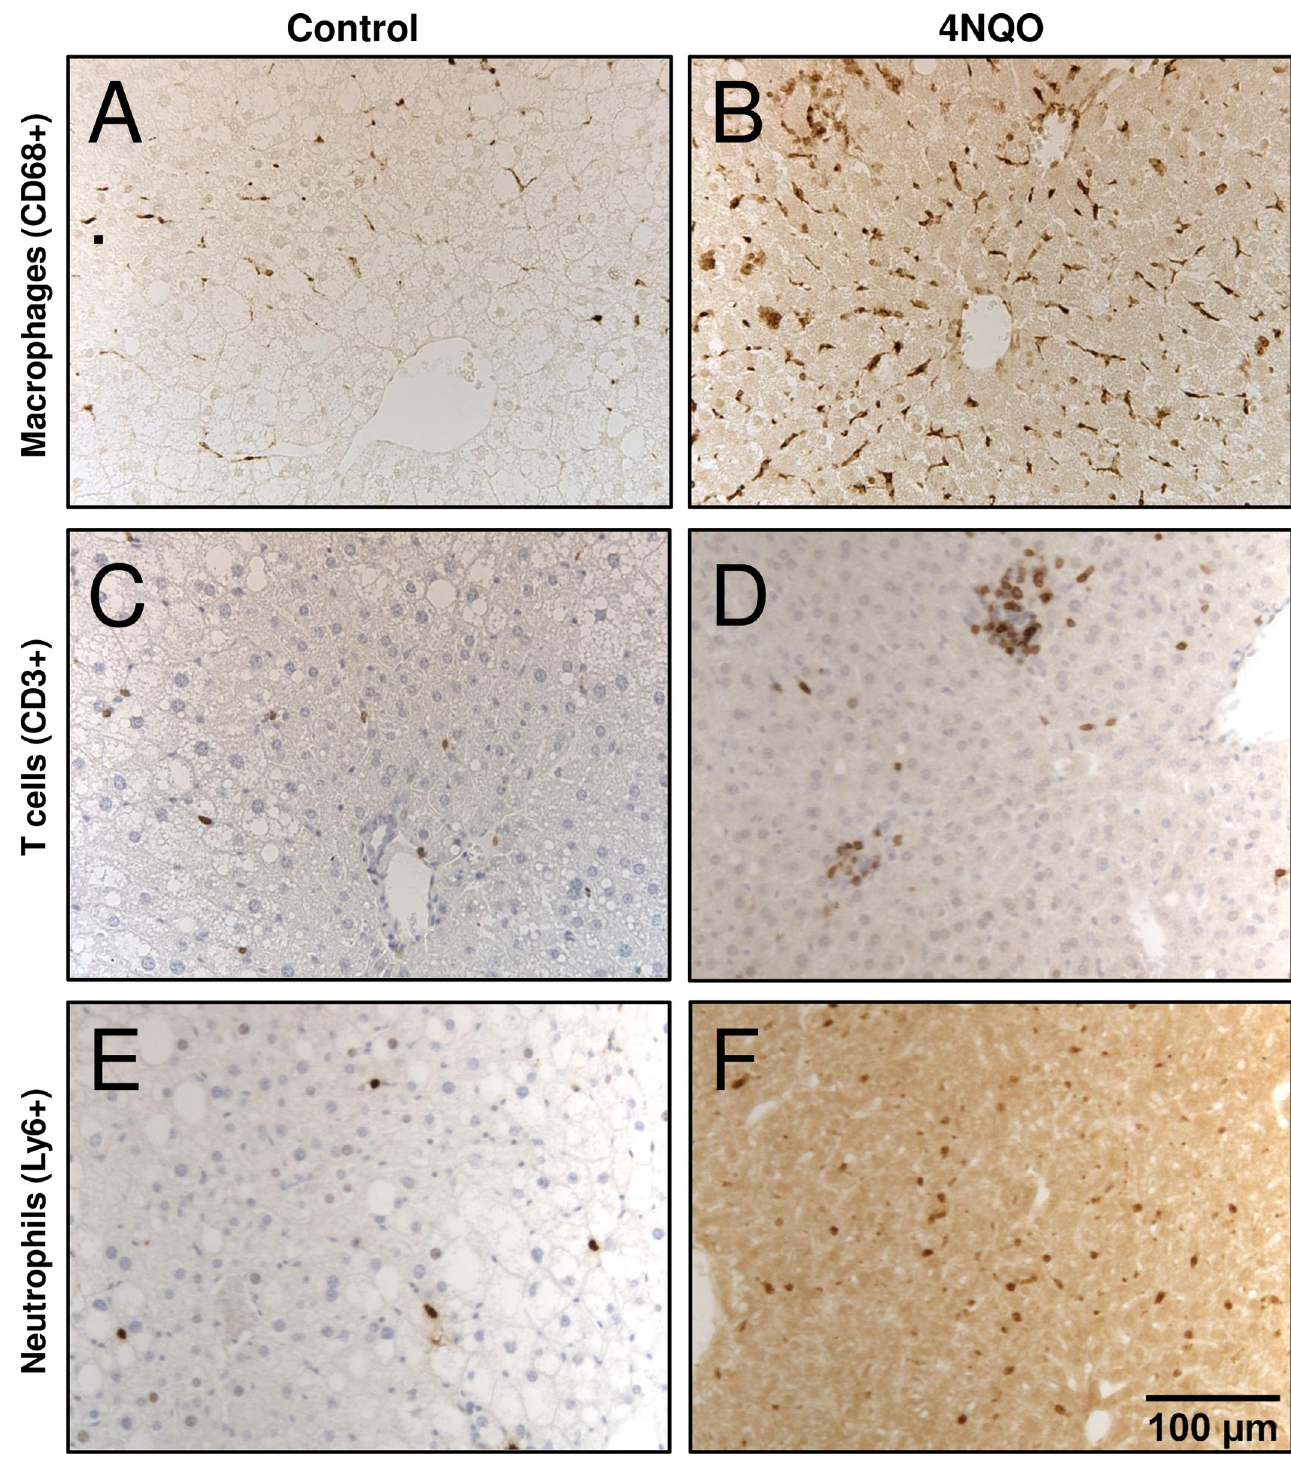
Fig 4. Lymphoid cell infiltration in representative liver sections from control mice or mice treated with 4NQO (200x). All hepatic samples are from male mice on a HF diet. (A) CD68+ macrophages in a control liver (B) CD68+ macrophages in a 4NQO-treated liver (C) CD3+ T cells in a control liver (D) CD3+ T cells in a 4NQO-treated liver. (E) Ly6+ neutrophils in a control liver (F) Ly6+ T cells from a 4NQO-treated liver.